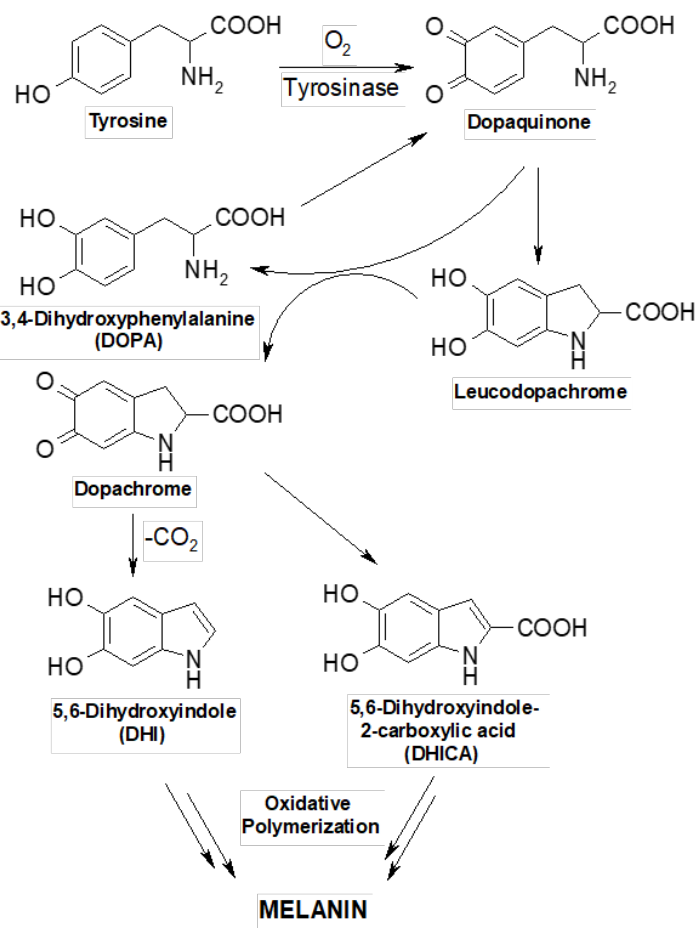
Figure 1. Biosynthetic pathway of eumelanins.